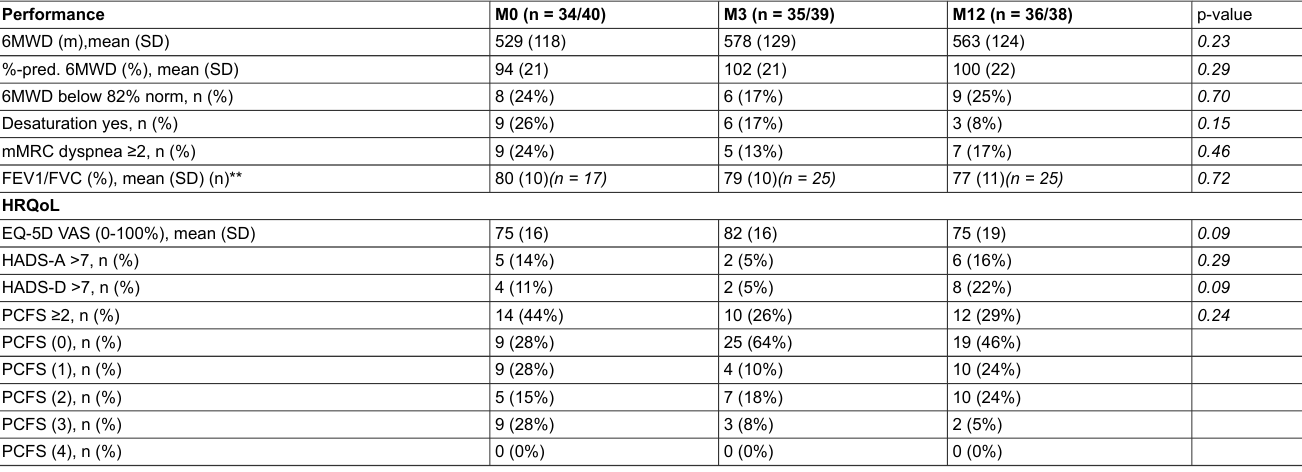
Table 2: Clinical data from first evaluation to one-year